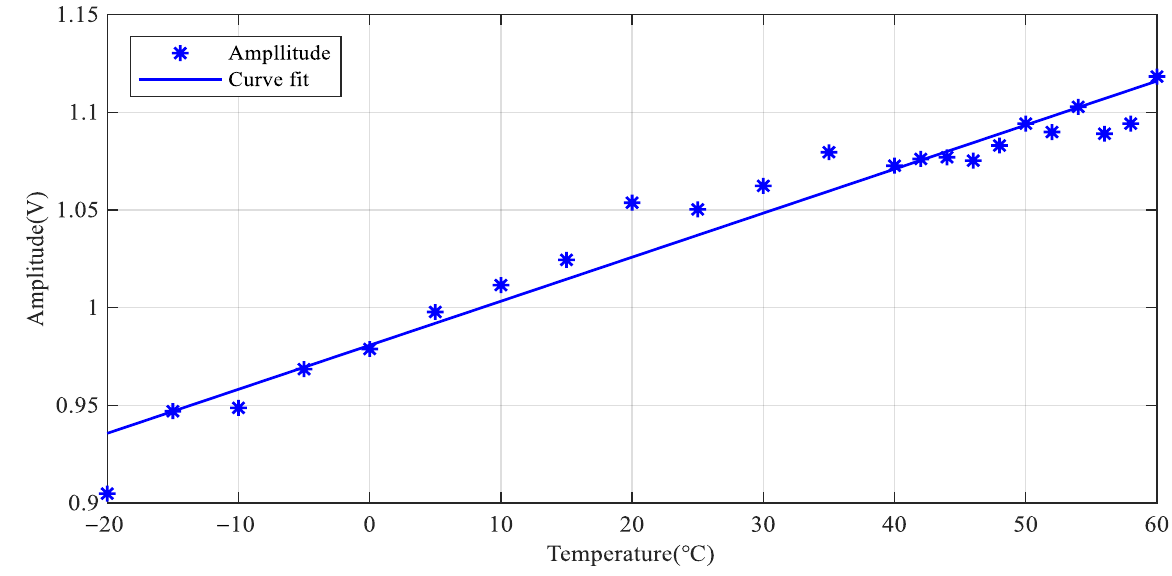
Figure 10. Amplitude change of LW signals at all temperatures.